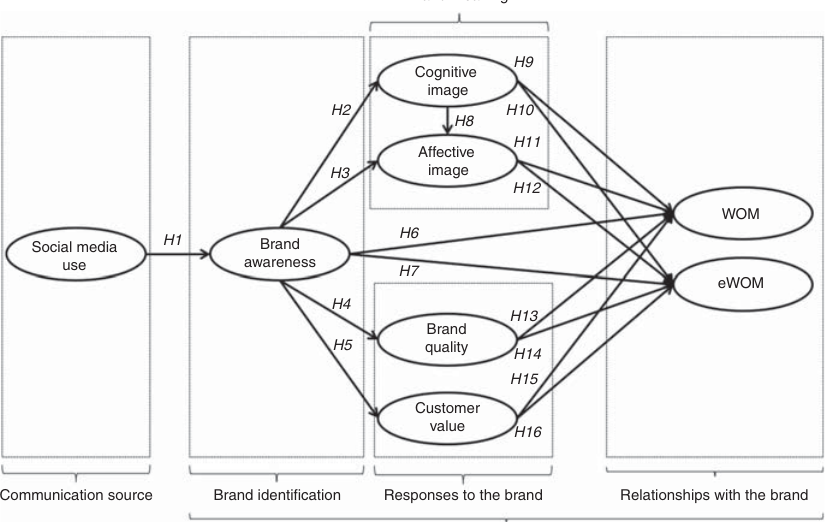
Figure 1. Proposed